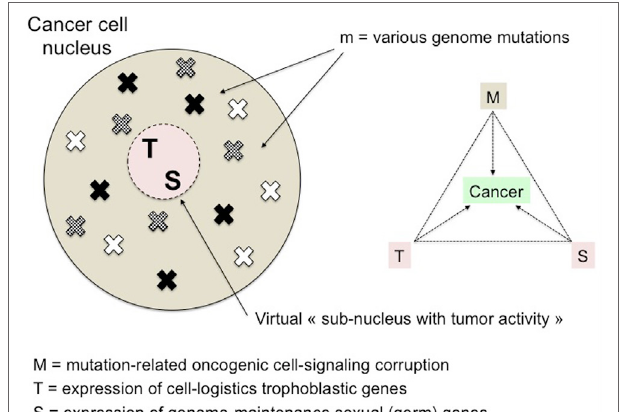
FigUre 2 | The epigenetic jumps backward leading to the malignant phenotype. Any cell of an individual derives downstream from the zygote after a lot of cell divisions, a very long epigenetic trip and possibly various mutations, certain of them promoting a precancerous state. Hence, the genes present in the zygote and in each of the subsequent cells are the same, yet with various structural and/or epigenetic alterations. We hypothesize that a precancer cell becomes malignant after it achieves epigenetic jumps backward leading to the reprogramming of normally turned off sexual and trophoblastic master genes. Malignant cell would be a phenotypic hybrid made of the primordial precancer cell supplemented by sexual-like and trophoblastic-like transdifferentiations. The probability of the process is infinitesimal and the mechanism still remains to be explored. The expression of oncofetal biomarkers could be a related collateral effect.